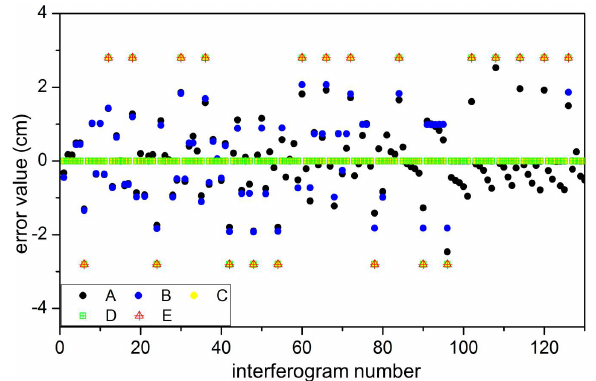
Figure 2. The error distribution diagram of the interferograms. We simulated the unwrapping error with an 18% uniform distribution, the 10m DEM error, the temporal decorrelation noise with a critical temporal baseline of 600 days, and an atmospheric delay with a standard deviation of 2mm. A is the residual error V obtained by LS; B is the true error Δ calculated by the preliminary quasi-accurate observations; C is the true error Δ calculated by the final quasi-accurate observations (step 3); D is the unwrapping errors estimated in the step 4; E is the simulated unwrapping